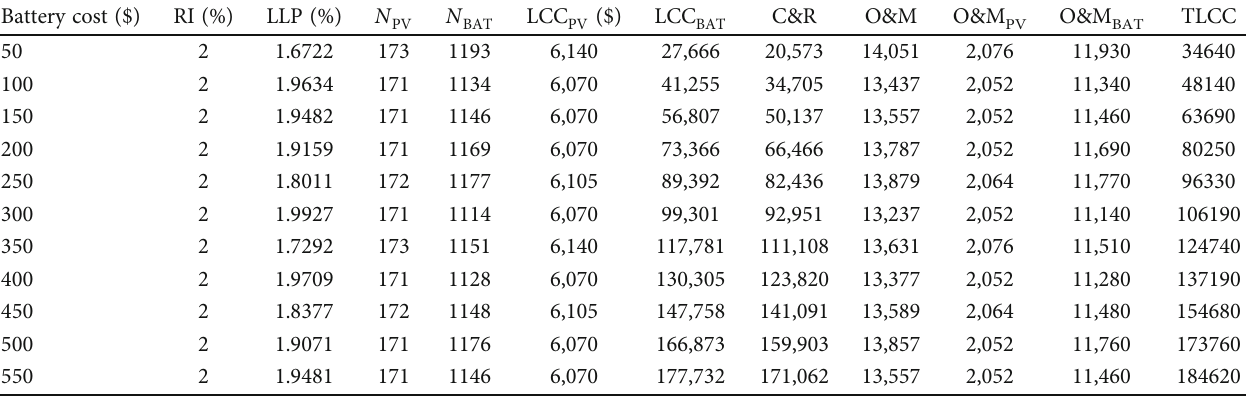
Table 4: The results of the variations of the battery unit cost on the optimal variables and cost criteria (in $) of the system. Battery cost ($)